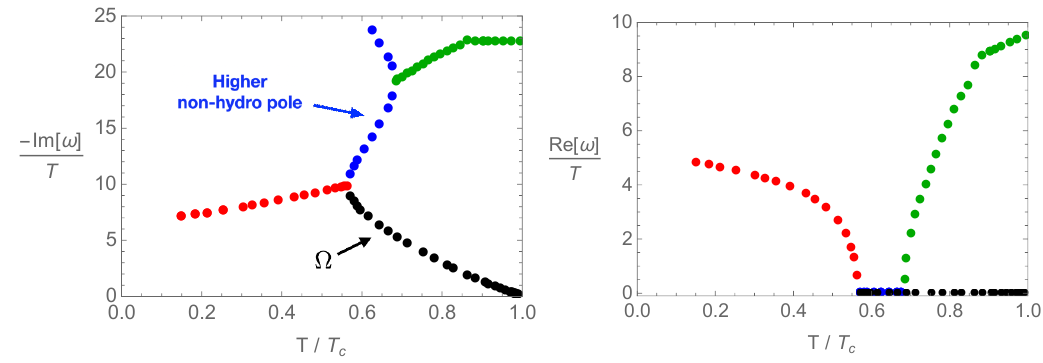
Figure 14 . The λ dependence of the dissipative coefficient ˜ σ and the mass ˜ ω A at T/T c = 0 . 9 . Left: ˜ σ vs. λ . The dashed line is the fitting formula ˜ σ/T = 0 . 33 λ/T . Right: ˜ ω the fitting formula ˜ ω = 1 . 55 p λ/T . A /T